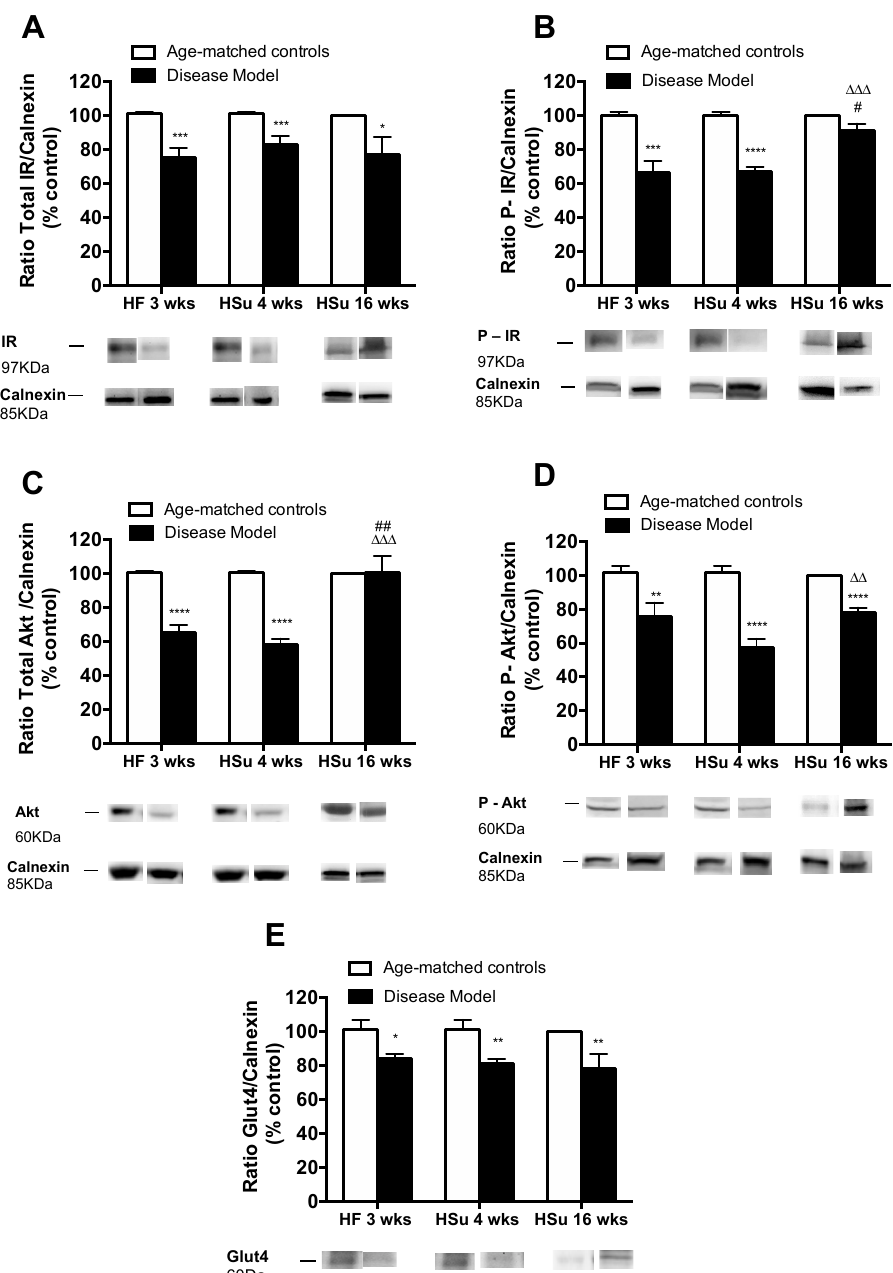
Figure 3. Alterations in the expression of proteins involved in insulin signaling in insulin-sensitive tissues in animal models of obesity and type 2 diabetes. ( A ) Total insulin receptor (IR) expression ( B ) phosphorylated IR expression; ( C ) total AKT expression; ( D ) phosphorylated AKT expression; ( E ) Glu4 expression. Below the graphs, representative bands from the Western blots for the correspondent proteins are shown. Bars represent means ± SEM; one- and two-way ANOVA with Bonferroni’s multiple comparisons test: * p < 0.05, ** p < 0.01, *** p < 0.001, and **** p < 0.0001 comparing age-matched controls with disease models; # p < 0.05 and ## p < 0.01 comparing HF 3 weeks with HSu 16 weeks; ΔΔ p < 0.01 and ΔΔΔ p < 0.001 comparing HSu 4 weeks with HSu 16 weeks.